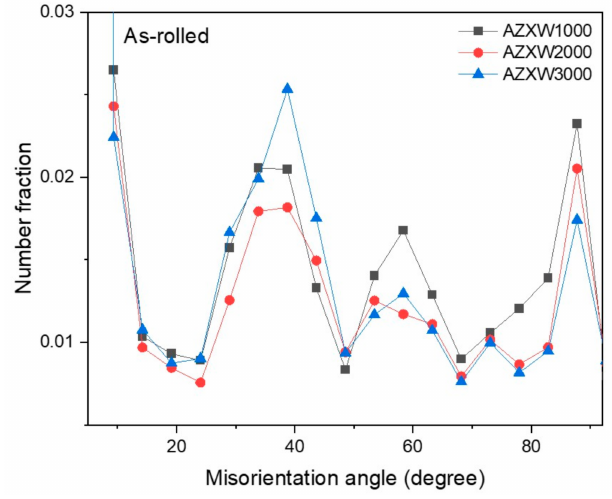
Figure 8. Misorientation angle distribution of the as-rolled AZXW1000, 2000 and 3000 sheets calcu- lated from the IPF maps in Figure